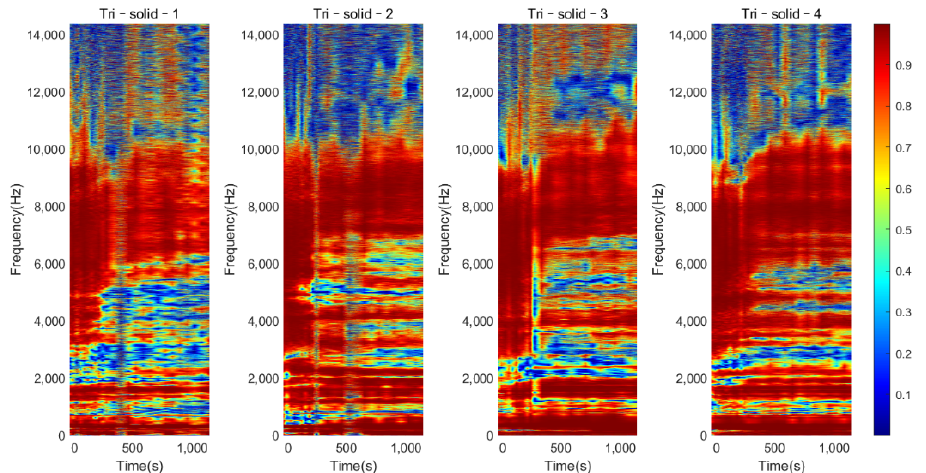
Figure 6. Plots of the coherence development against the cure time for triangular implants with a solid IM stem.